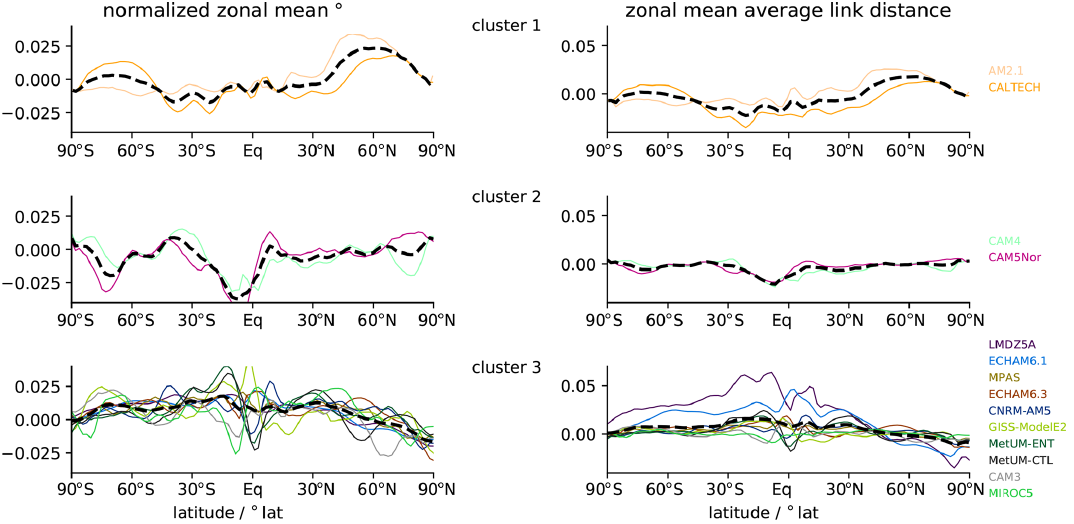
Figure 9. Differences in the zonal-mean network properties of the AquaControl versus Aqua4xCO2 global networks for the three identi- fied clusters. The left panels show the normalized difference between the zonal-mean degrees of the AquaControl and Aqua4xCO2-based networks, while the same is shown in the right panels for the respective average link